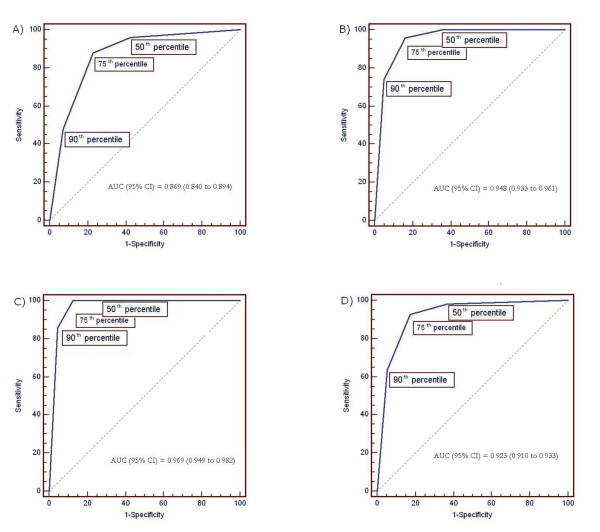
ROC curves during different hours of age: A) 24-48 h; B) 49-72 h; C) 73-96 h; D) 24-96 h. (AUC area under the curve).